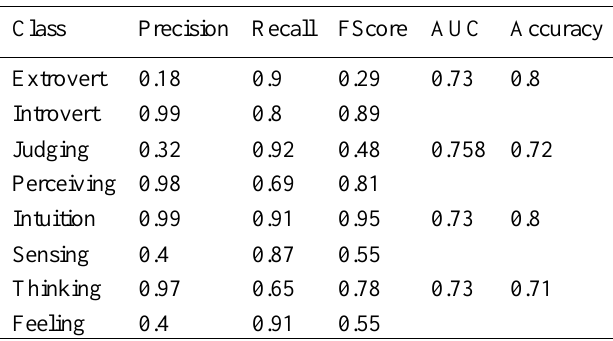
K-Nearest neighbour result with feature selection